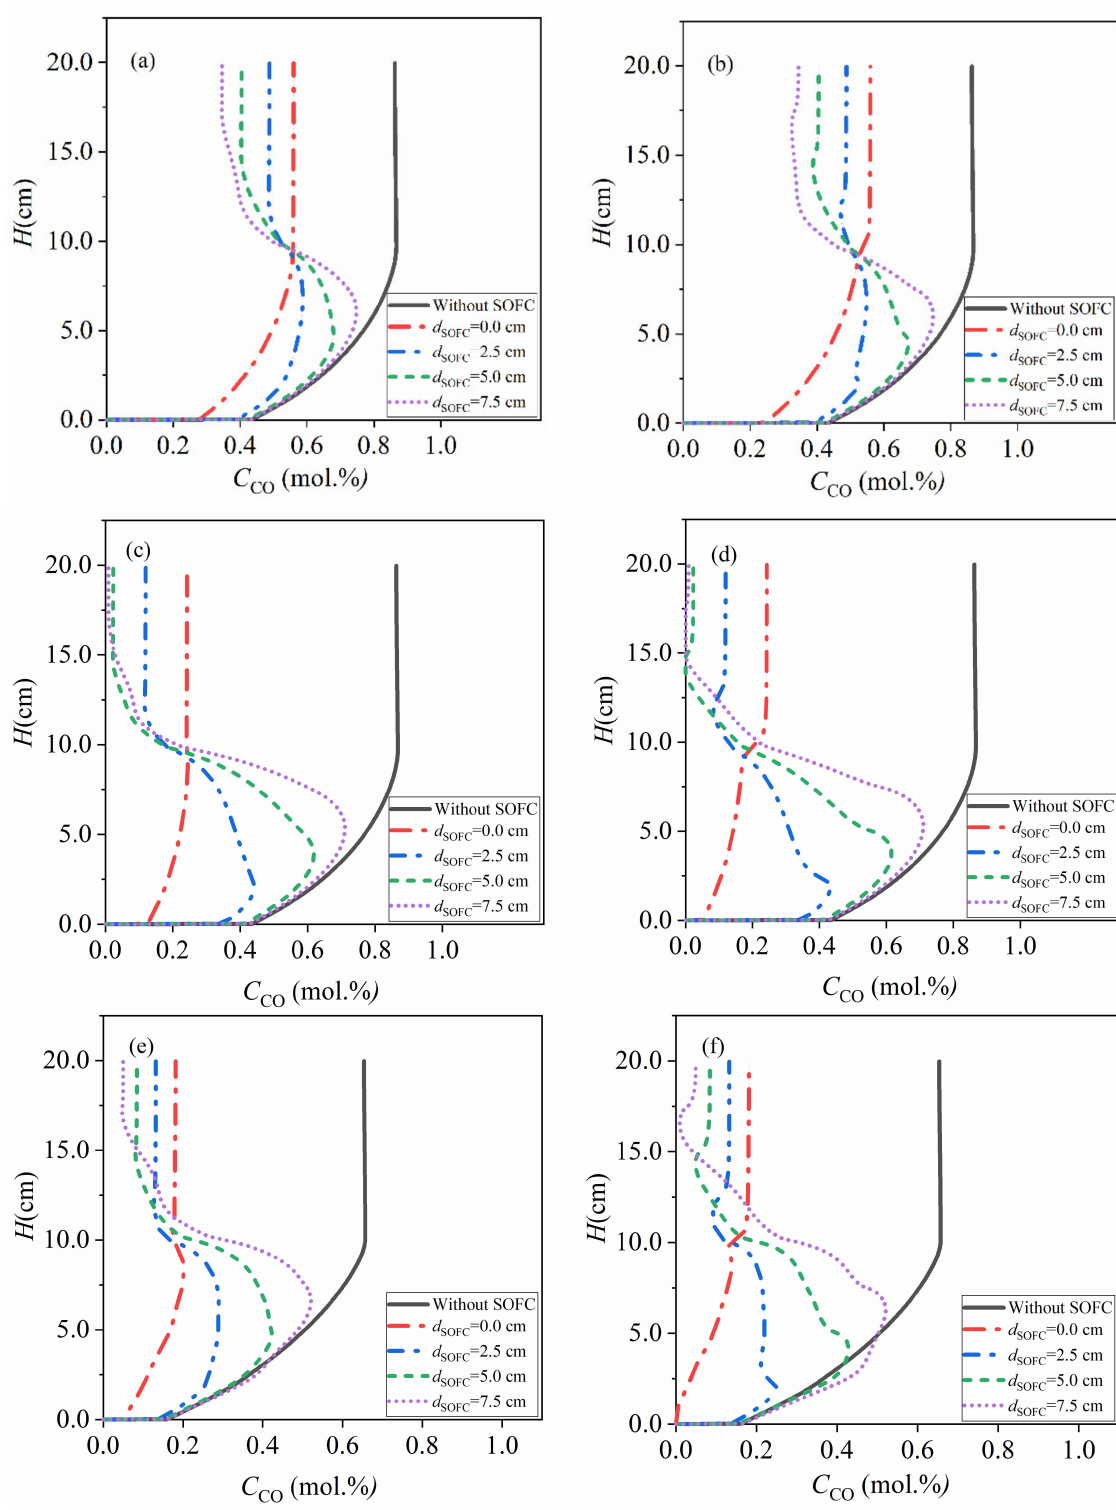
Figure 7. Averaged CO molar fractions ( a , c , e ) and CO molar fractions near side walls ( b , d , f ) along channel for fixed bed gasifiers coupled with SOFCs with A s = 7.2 × 10 − 6 mol/m 2 . ( a , b ) 1000 A/m 2 , v CO v CO = 0.2 cm/s; ( e , f ) 2000 A/m 2 , v CO = 0.5 2 ,in 2 ,in